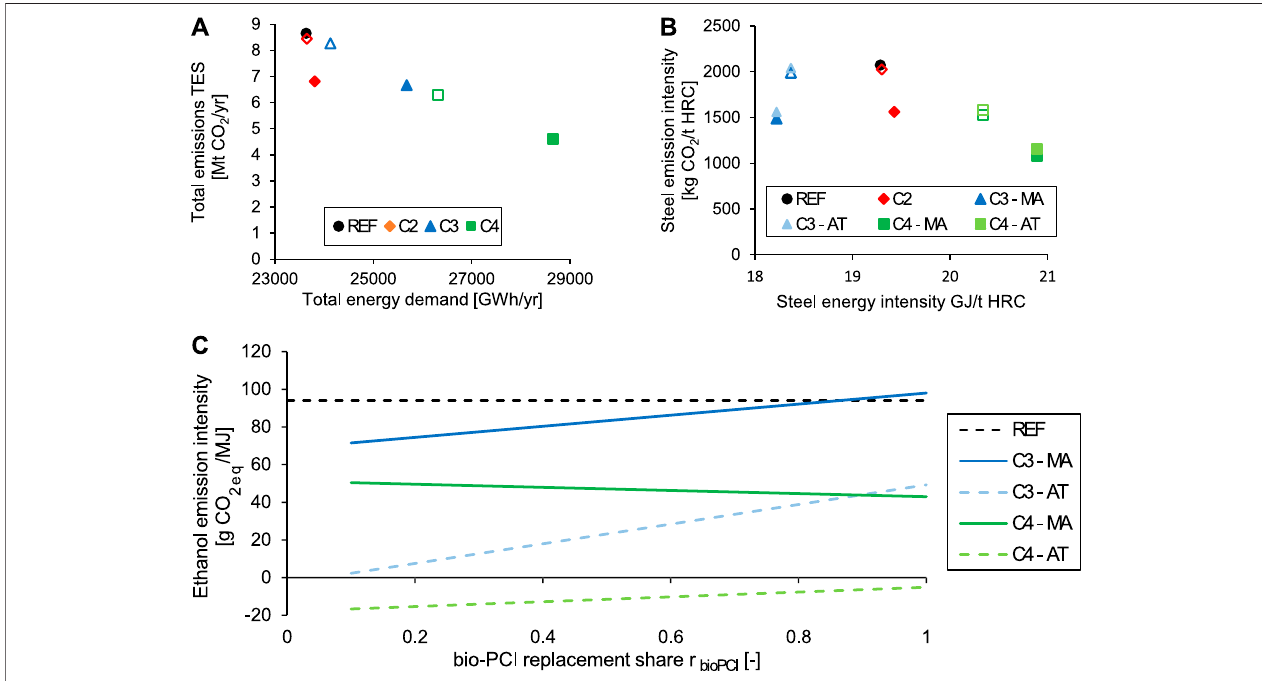
FIGURE14| Impactsofintensi fi edmitigationtechnologiesonthetotalemissionsinTESforanintegratedsteelmillof4 MtHRCperyear (A) ,andthecorresponding CO 2 emissionintensitiesofsteel (B) andethanol (C) .Thenon fi lledsymbolsrepresentthedefaultsettings,thatis,90%CO 2 capturefromBFGand10%Bio-PCI;the fi lled symbols represent 99% CO 2 capture from BFG and 100% Bio-PCI. AT, attribution; C2, con fi guration with Bio-PCI and electricity export; C3, con fi guration with Bio-PCI and ethanol production; C4, con fi guration with ethanol production and CCS; MA, mass allocation; REF, reference (C1). The grid intensity is 0 gCO 2 /kWh.